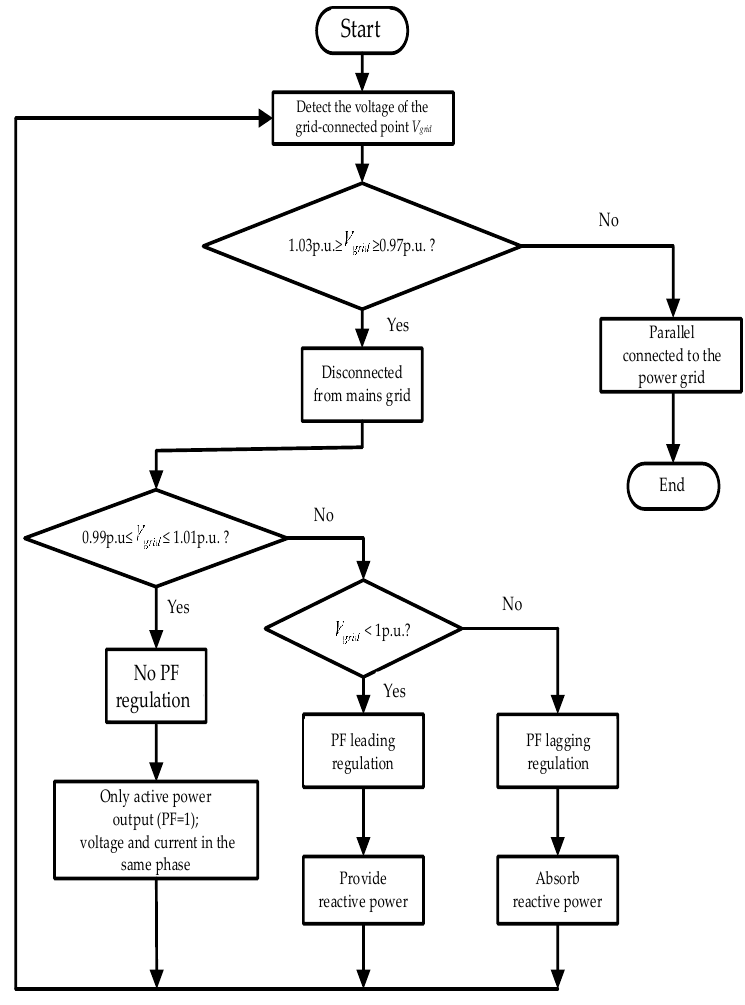
Figure 10. Voltage-power control flow chart.